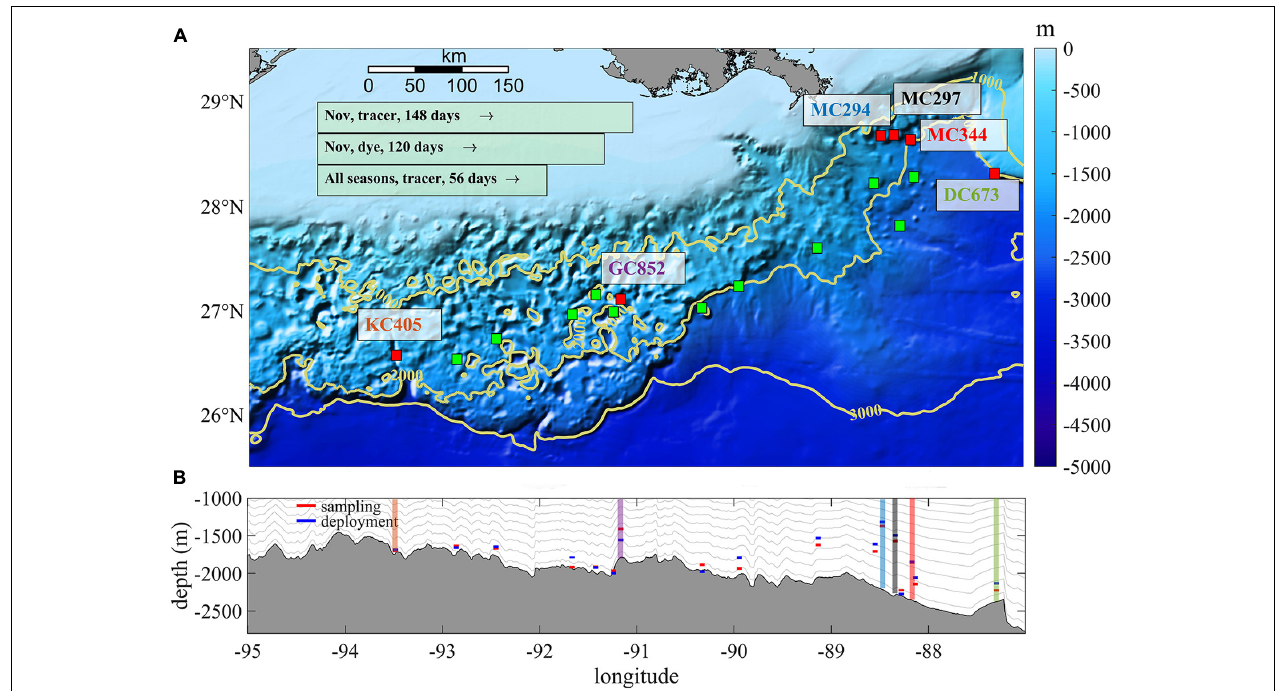
FIGURE 1 | (A) Topography map of the study area showing the sampled and predicted sites hosting P. biscaya populations. (A) Red boxes (0.05 × 0.05 ◦ ) with colored textbox indicates six main sites (from east to west, DC673, MC344, MC297, MC294, GC852, and KC405). Green boxes with black edge are predicted intermediate suitable habitats selected from models by Georgian et al. (2020). Yellow contours indicate 1,000, 2,000, and 3,000 m isobaths. Light green boxes at the up left corner summary three release strategies in this work. (B) The gray shaded area shows the topographic profile of the northern GoM averaged between 1,000 and 3,000 m. The colored boxes indicate the depth where corals were collected (red) or larval particles released (blue). Gray lines show the average depth of the s-layers in our